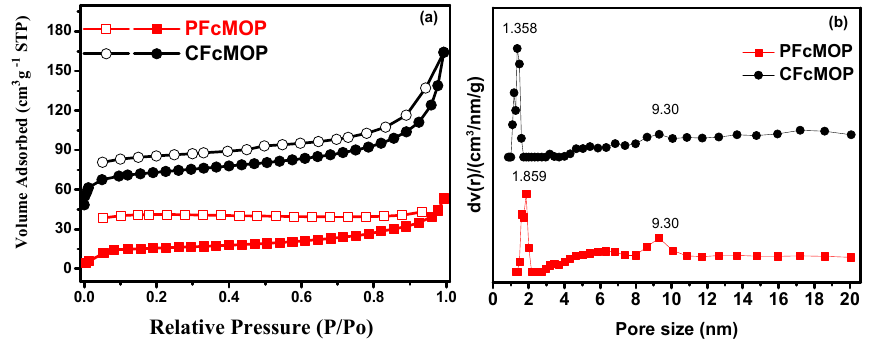
Figure 3. N 2 adsorption–desorption isotherms ( a ) and pore size distribution curves ( b ) of PFcMOP and CFcMOP.